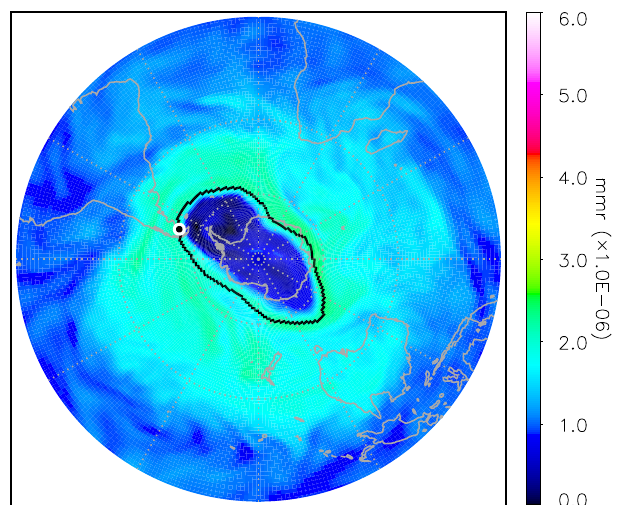
Fig. 18b. The vortex edge overplotted on top of the ERA-Interim ozone mass mixing ratio (mmr) at 430K for 13 November 2009. The location of Río Gallegos is indicated by the black-in-white cir-